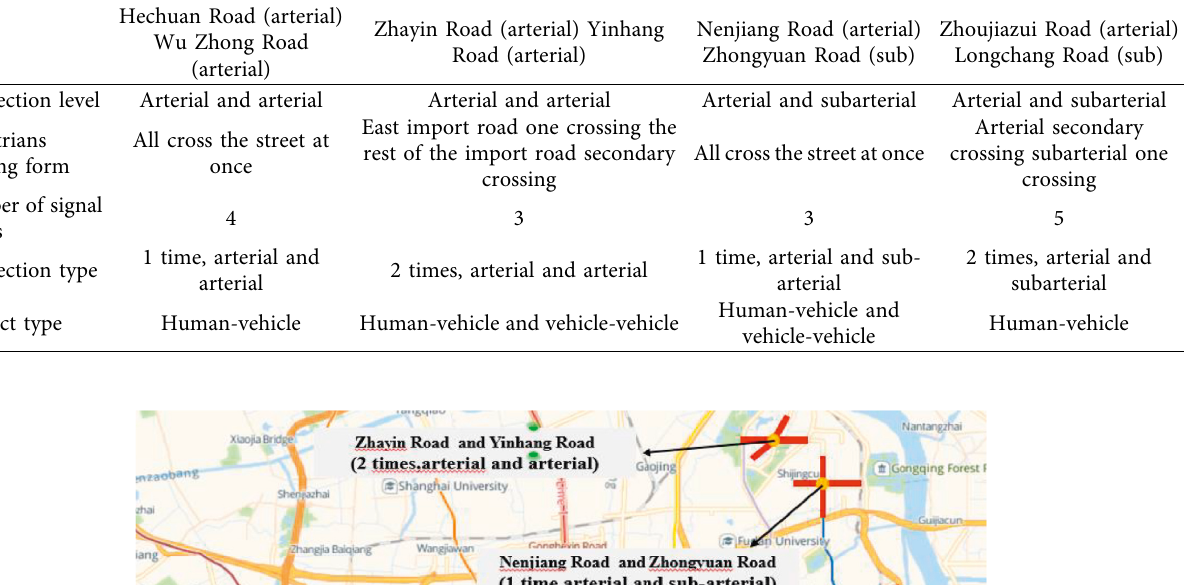
Table 1: Signal phase and pedestrians crossing pattern of intersections surveyed.